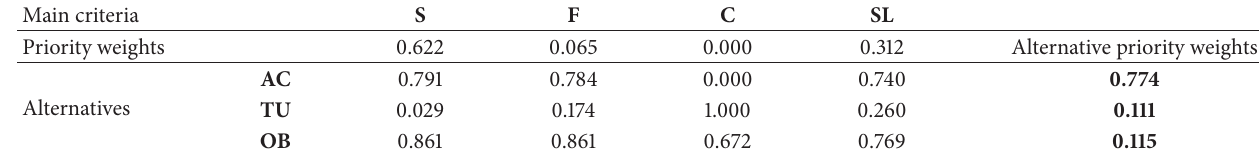
Table 10: Summary combination of priority weights: main criteria of the goal.